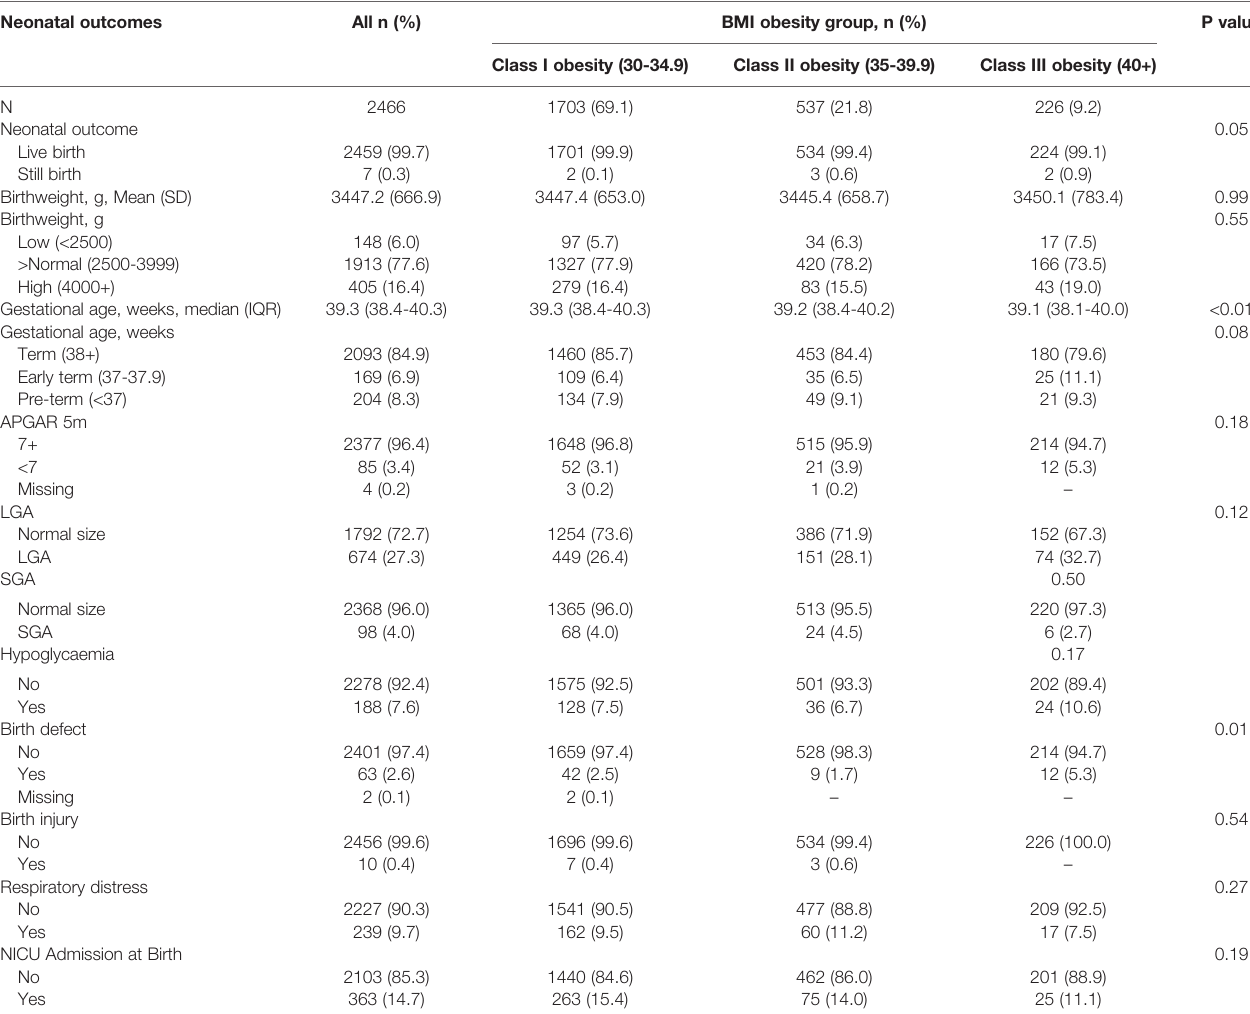
TABLE 3 | Neonatal outcomes by obesity